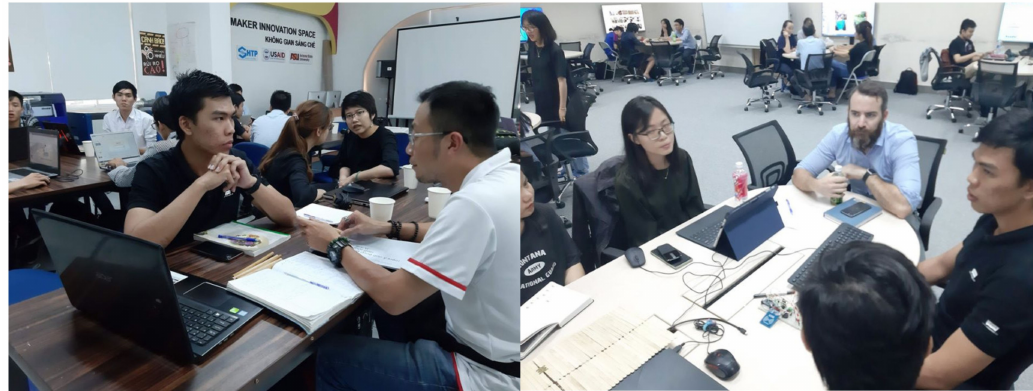
Figure 27. Discussions in Mentoring Event at the Maker Innovation Space (left) and Digital Learning Classroom